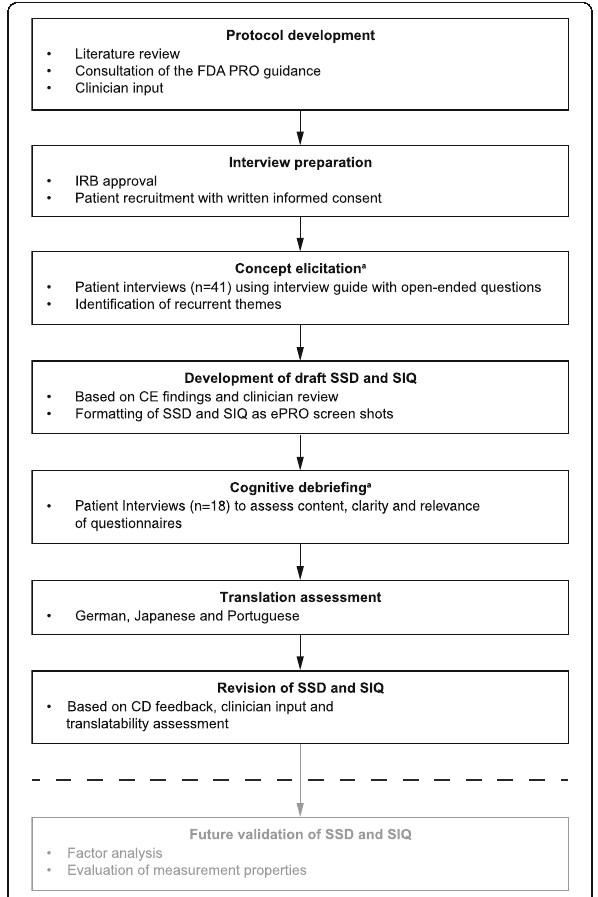
Fig. 1 PRO development process. a Distinct groups of